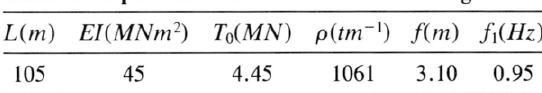
Table 1. Specifications of the Umenoki Bridge